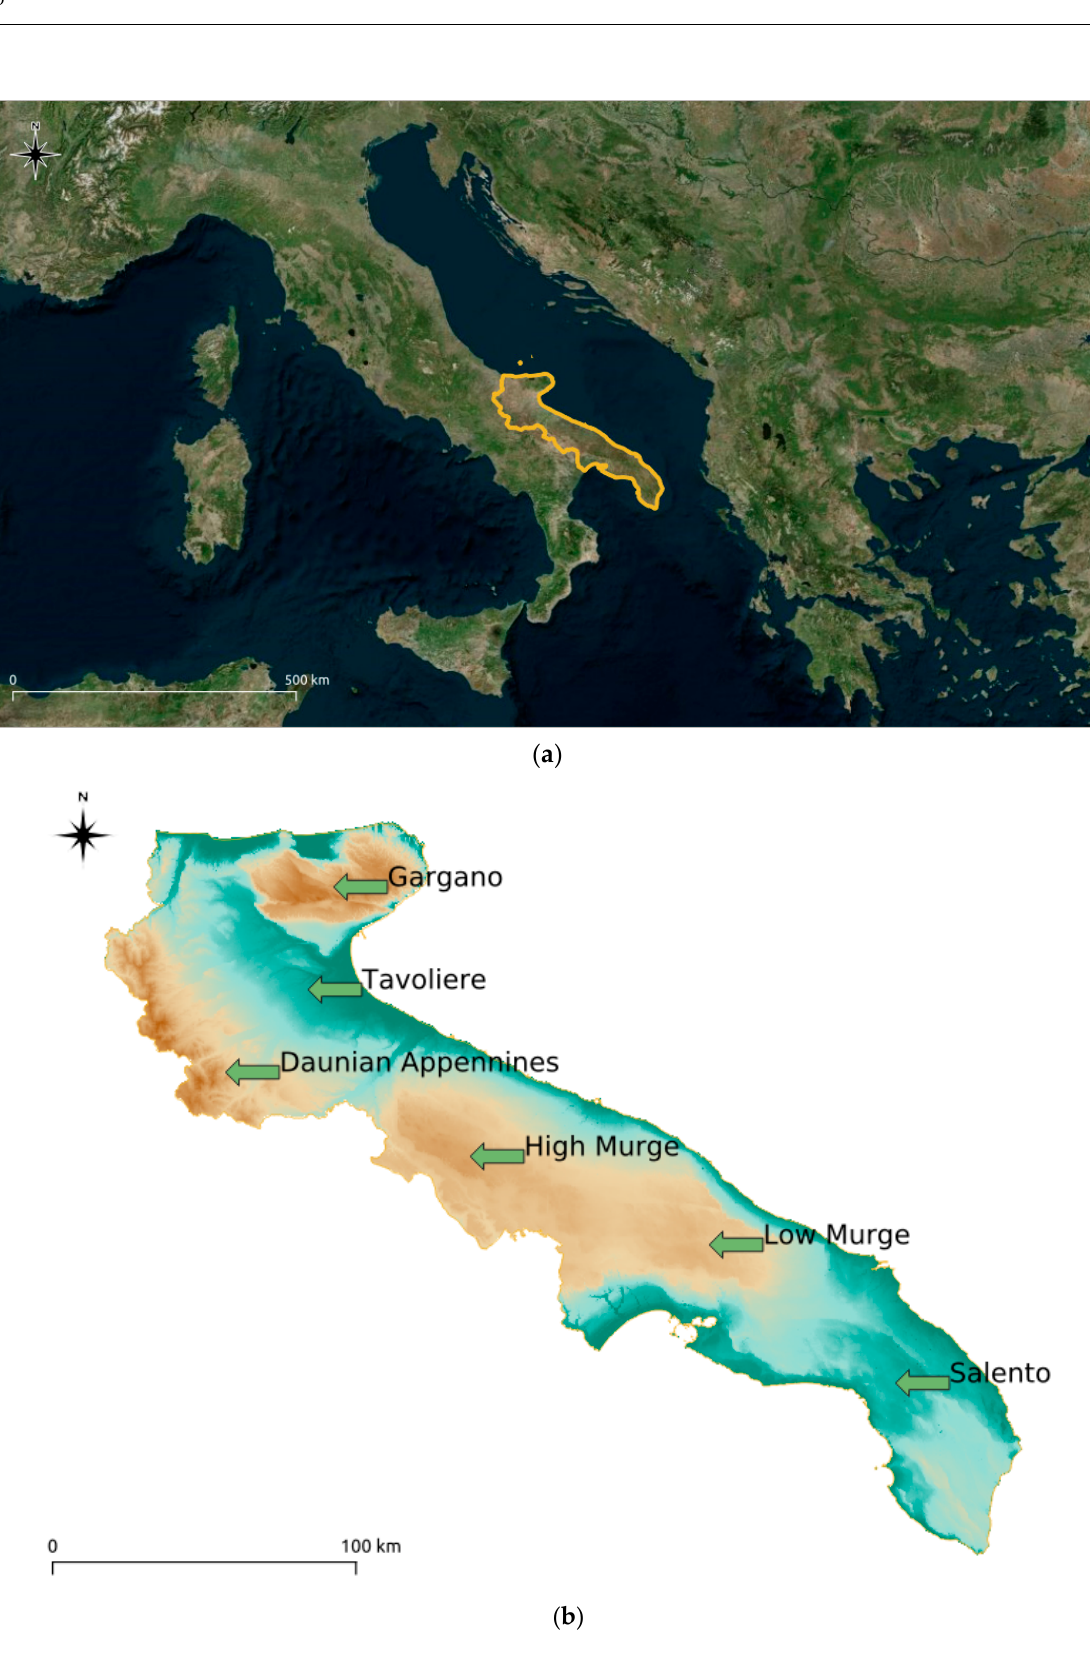
Figure 2. ( a ) Administrative limits of the Puglia region (Base map from Bing Maps). ( b ) Geographical subdivisions based on the morphology of the territory of the Puglia region (Base map from SIT Puglia [74]) .